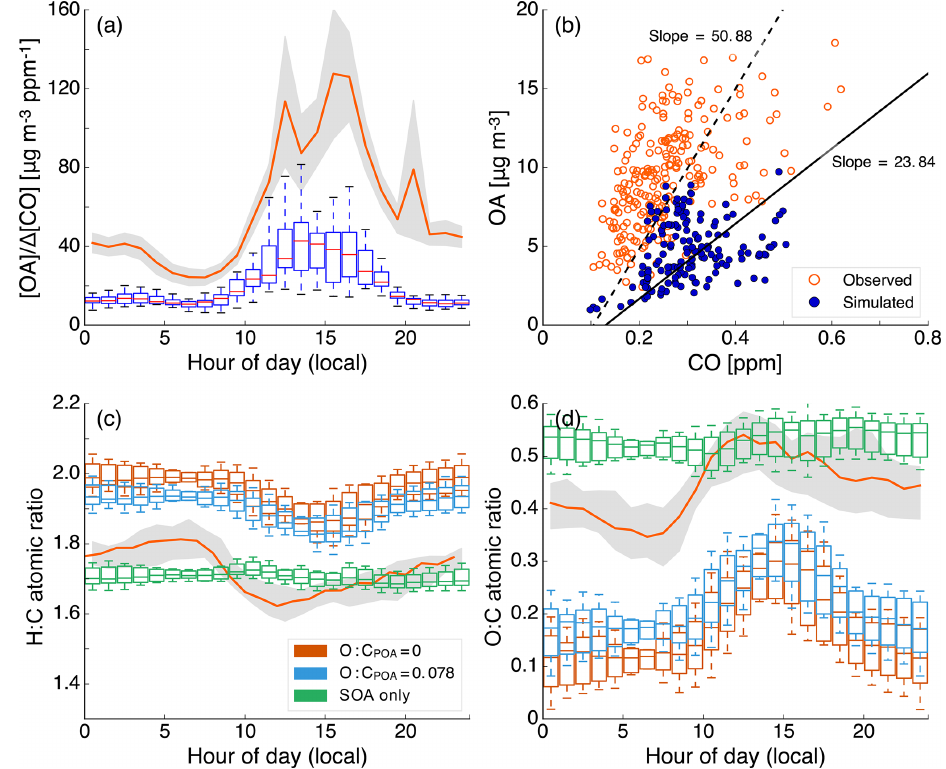
Figure 9. (a) Diurnal profile of the modeled and measured OA /(cid:49) CO ratios at Riverside, CA. The box plots capture the 10th, 25th, 50th, 75th, and 90th percentile in model predictions over the simulated episode, while the gray bands and solid orange line represent the 10th and 90th percentile and median of the measured data. (b) Modeled and measured OA mass concentrations plotted against CO concentrations between 10:00 and 20:00 local time. The solid and dashed black lines represent lines fitted to the modeled and measured data by forcing the x intercept to be the corresponding modeled and measured background CO concentration. Diurnal profiles of the modeled and measured (c) H : C and (d) O : C ratios of the OA (corrected as per Canagaratna et al., 2015). The three different predictions show results from the Base simulations for OA assuming no change, the POA O : C fixed to 0.078 based on the measurements of Docherty et al. (2011), and no